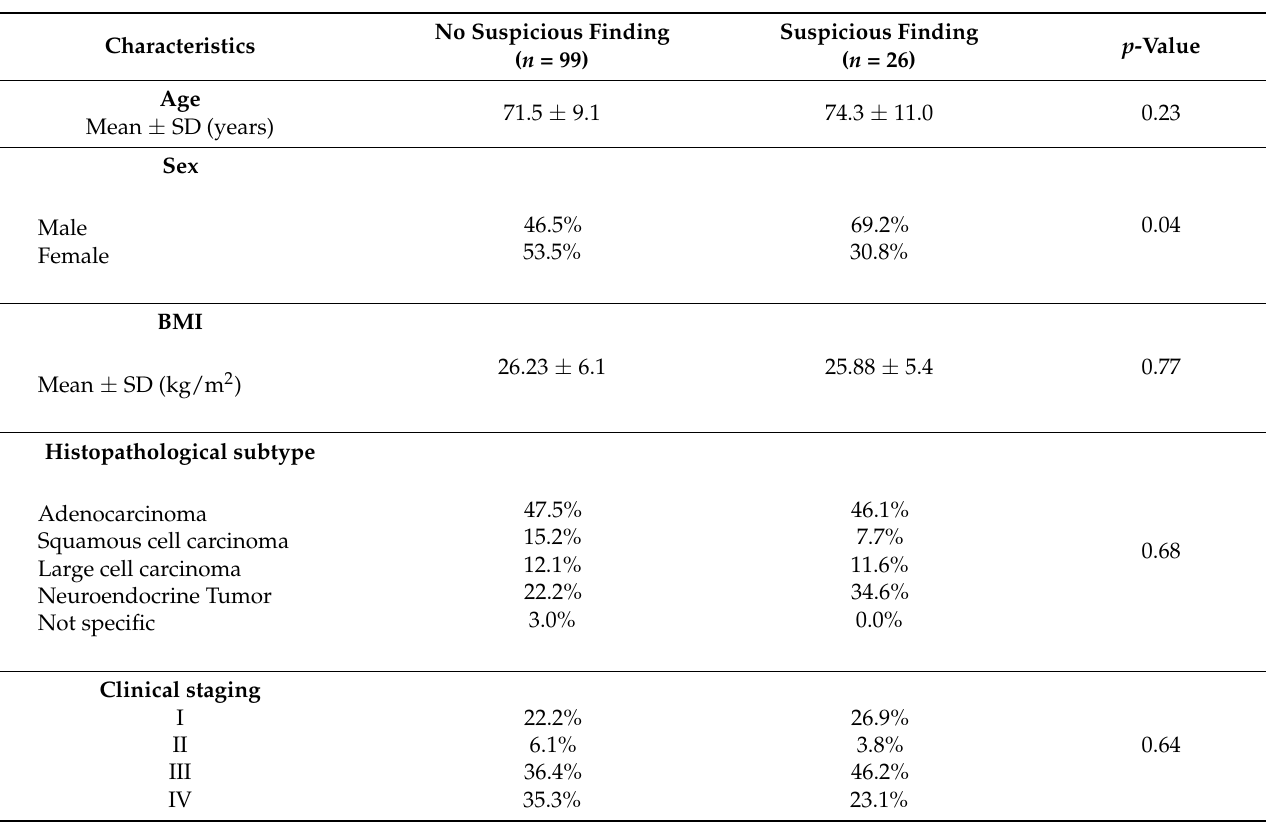
Table 1. Baseline characteristics of all included patients with first diagnosis of NSCLC ( n = 125) with findings suspicious of additional malignancy ( n = 26) and without suspicious findings ( n =